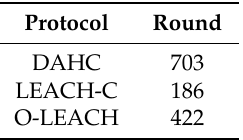
Table 5. The round of the FND when the BS (base station) is outside.